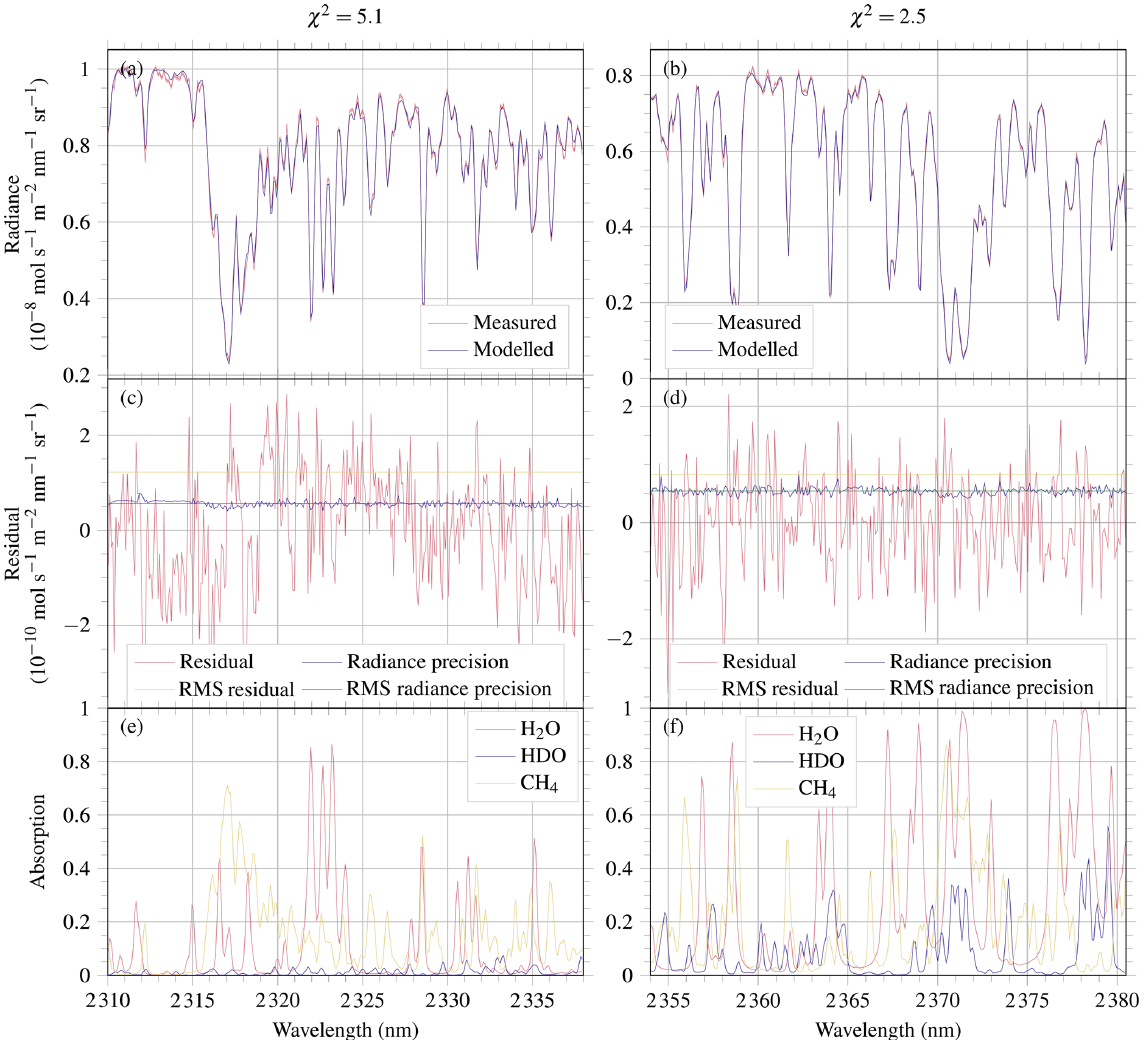
Figure 3. Observed TROPOMI radiance (red) and spectral fit (blue) in (a) the pre-fit window and (b) the final window for ground pixel 511754 in orbit 4924 located near Karlsruhe (7.8 ◦ E, 49.2 ◦ N) on 25 September 2018. Corresponding residuals (defined as measured minus modelled radiances, in red) and its root mean square (RMS, in yellow), precision of the radiance (in blue) and its RMS (in green) in (c) the pre-fit window and (d) the final window. Simulated absorption by H 2 O (red), HDO (blue) and CH 4 (yellow) in (e) the pre-fit window and (f) the final